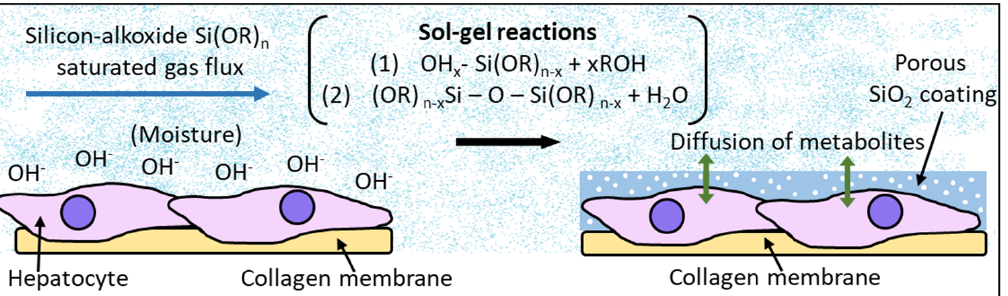
Figure 18. Porous sol-gel silica coatings on cell cultures generated by the biosil method, adapted from the information provided by M. Muraca et al. [90].